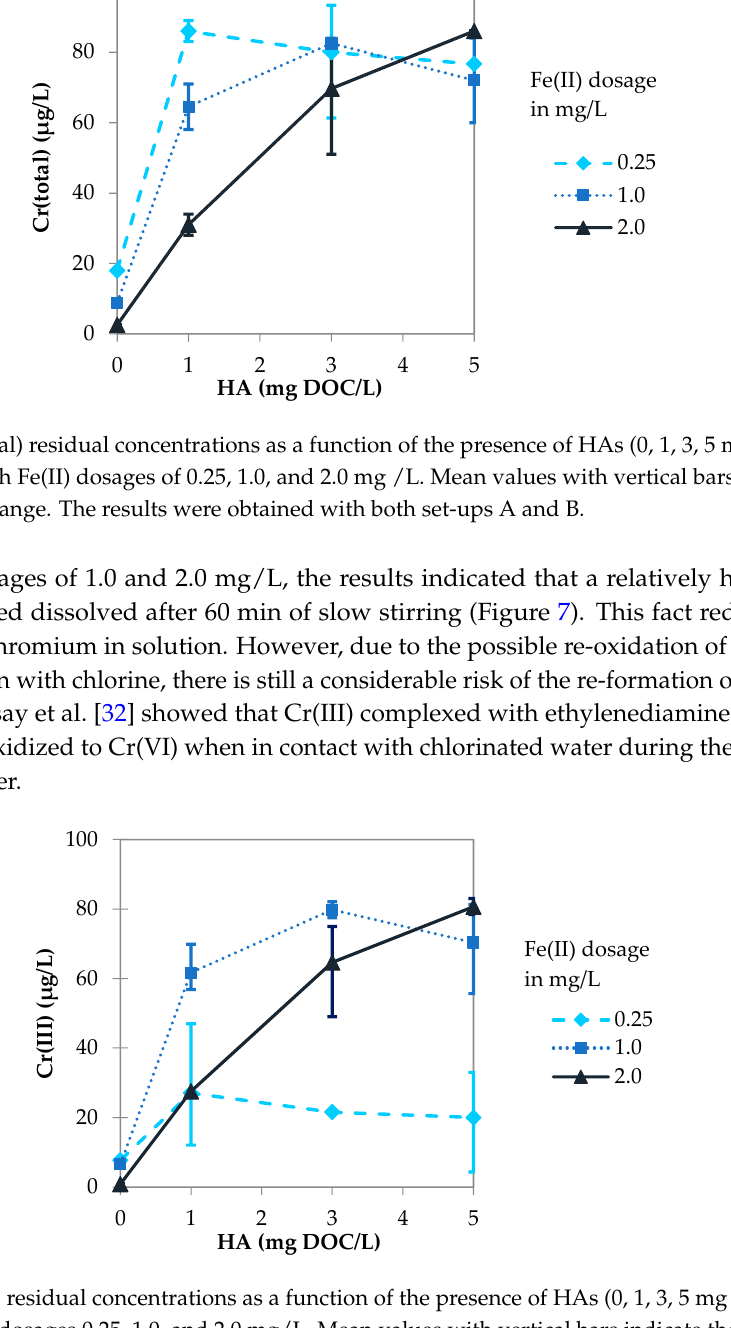
Figure 7. Cr(III) residual concentrations as a function of the presence of HAs (0, 1, 3, 5 mg DOC/L) at pH 7 and Fe(II) dosages 0.25, 1.0, and 2.0 mg/L. Mean values with vertical bars indicate the respective range. The results were obtained with both set-ups A and B.